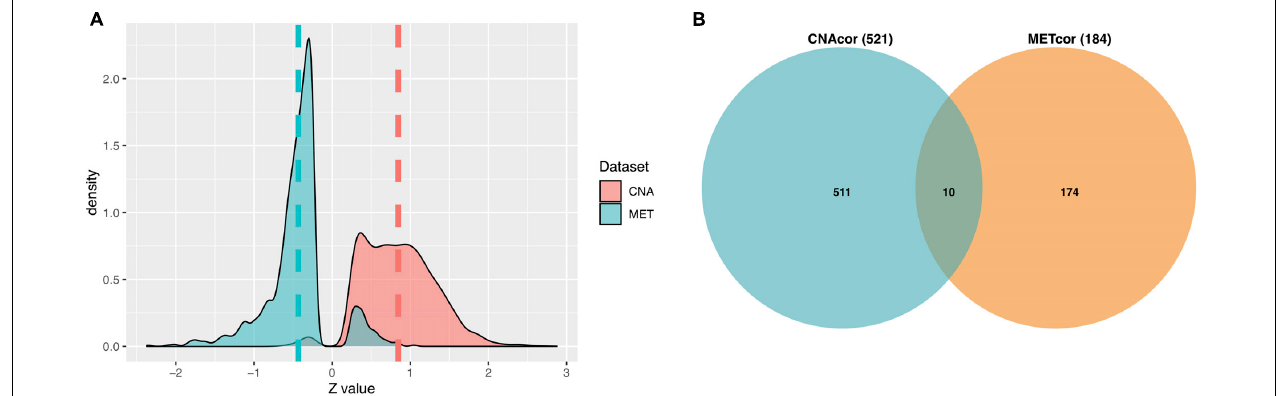
FIGURE 2 | Characteristics of CNAcor and METcor genes in BRCA. (A) The distributions of the Z-scores that represent the correlation between MET or CNA with corresponding mRNA. (B) Intersection between the number of CNAcor genes and the number of METcor genes. CNA, DNA copy-number aberration and MET, epigenetic DNA methylation.